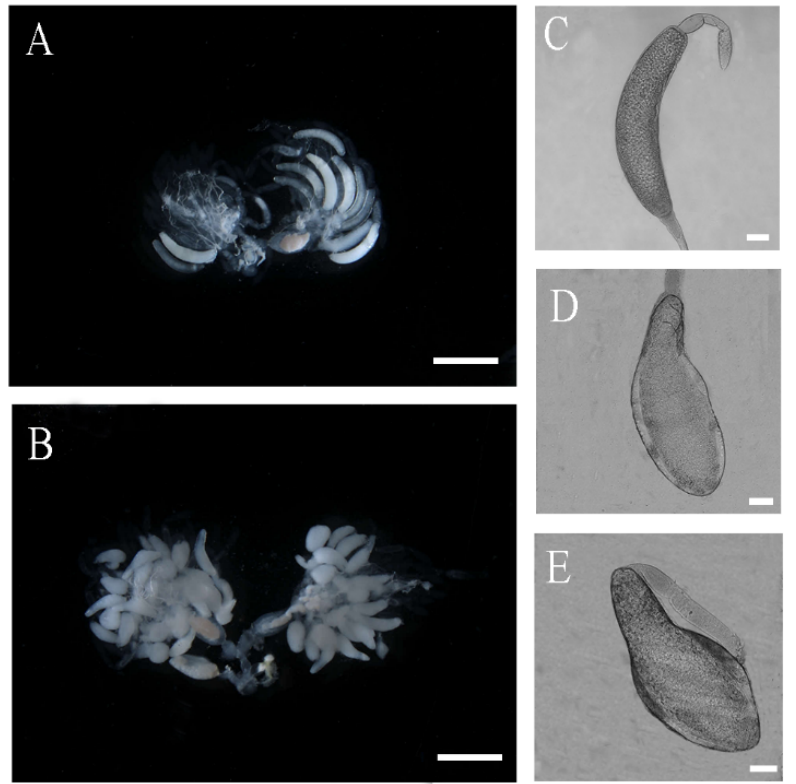
Figure 4. Effect of ds NlPCE3 on Nilaparvata lugens ovarian development. ( A ) Ovaries of a control female adult treated at 5 th day after ds GFP injection. ( B ) Ovaries of a female adult at 5 th day after ds NlPCE3 injection. ( C ) Normal mature egg. ( D – E ) Abnormal egg. Scale bar: 1 mm ( A , B ); 100 µ m ( C – E ).